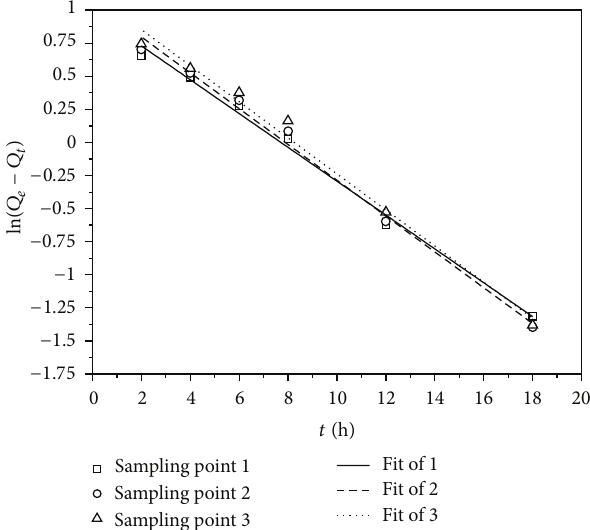
Figure 3: Effect of contact time on OTC adsorption onto sediment samples. Figure 4: Simulated results of pseudo-first-order kinetics.